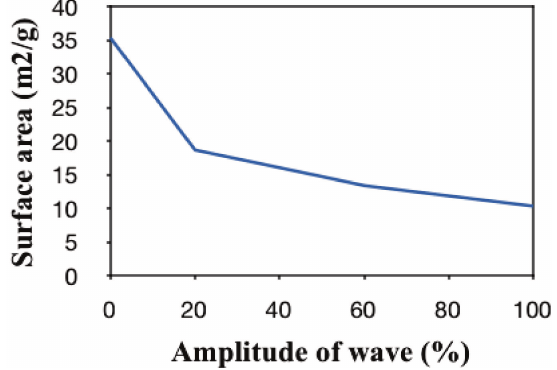
Figure 5. Surface area analysis (m 2 /g) vs. amplitude found for samples subjected to ultrasonic treatments.